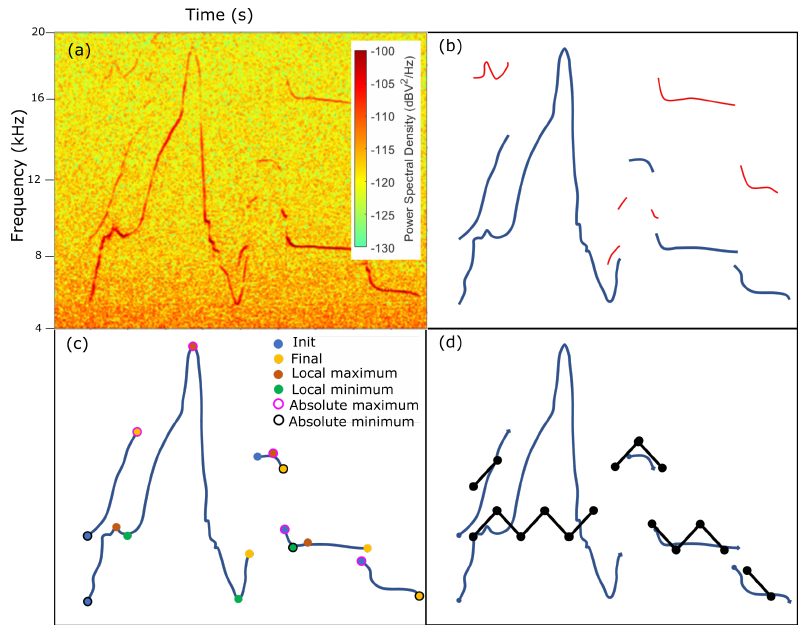
Figure 6. Acoustic analysis process exemplified by ( a ) a 2-second fragment of the spectrogram, ob- tained by applying a fast Fourier transform (4096 sampling windows and 50% overlap), ( b ) simplified spectrogram with quality cuts applied to harmonic and whistle durations: the blue color depicts the whistles considered in the analysis, the red color depicts the whistles that do not meet the conditions imposed by the applied quality cuts and, therefore, are neglected, ( c ) simplified spectrogram with the identification of contour properties linked with frequency properties, ( d ) simplified spectrogram overlapping the morphology classification based on the point of infection and slope determination for each